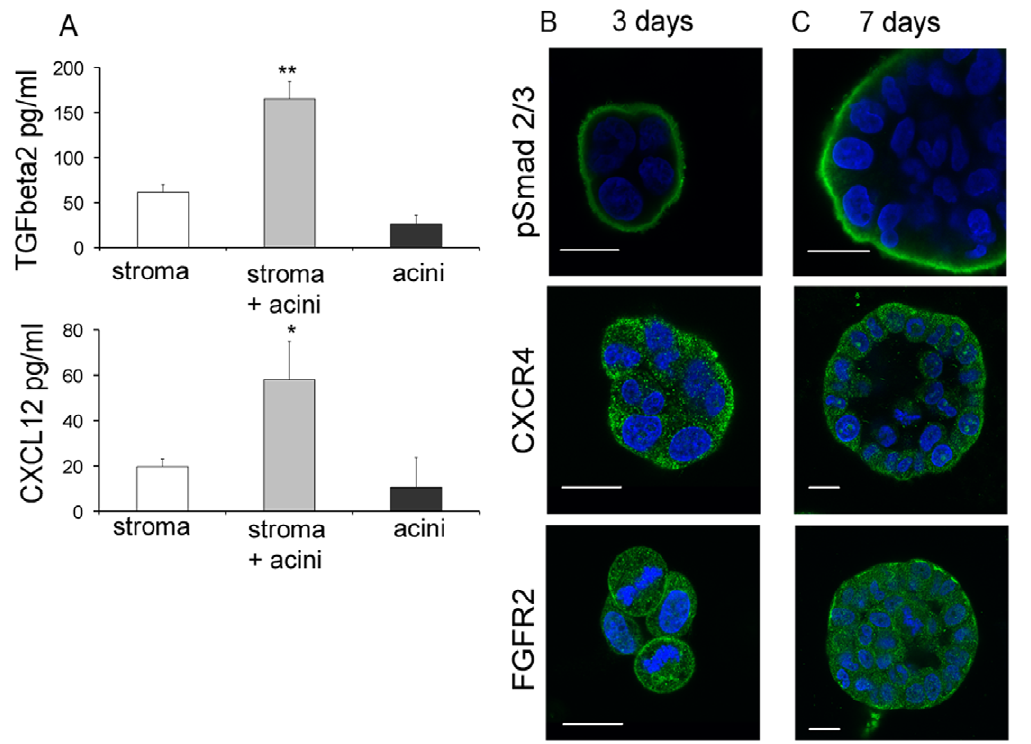
Figure 5. Paracrine signalling of TGF b 2, CXCL12 and FGF10. (A). Protein levels of TGF b 2 or CXCL12 were determined using ELISA. Medium was collected after 3 days growth from stroma or 3D BPH-1 acini cultured alone or in co-culture (n=6). The datum is typical of results from three separate stroma, **=p , 0.05 (paired t-test). (B and C). 3D BPH-1 acini were fixed at day 3 and day 7 and immunostained for pSmad 2/3, CXCR4 and FGFR2 (green), imaged at mid sections, DAPI (blue), bars =20 m